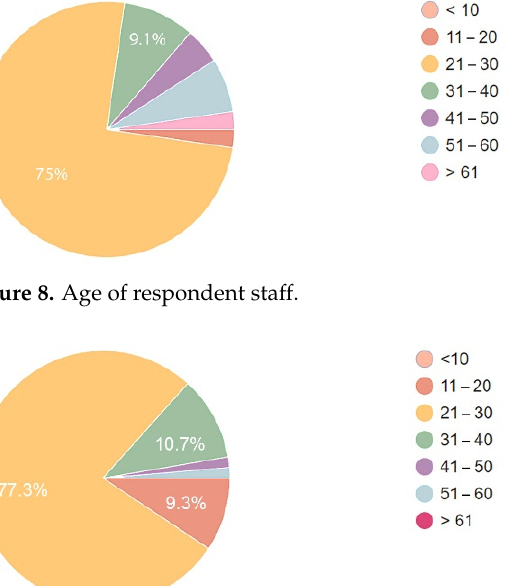
Figure 9. Age of respondent patients.